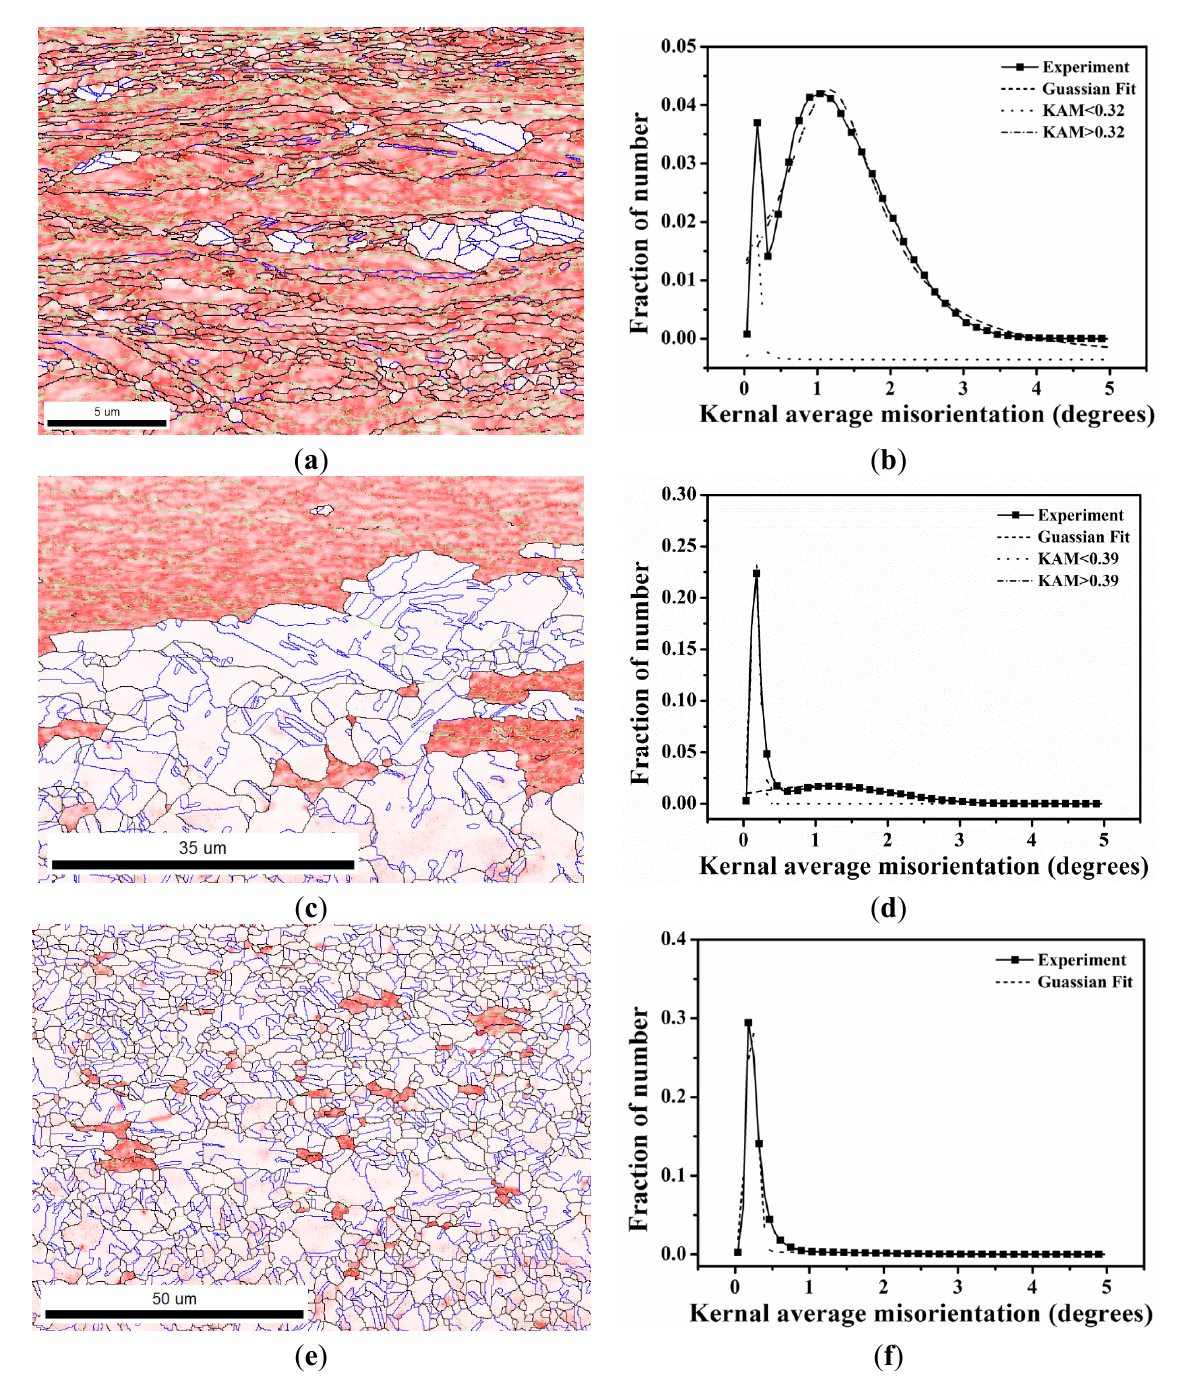
Figure 2. KAM maps after ( a ) 10 s; ( c ) 20 s; and ( e ) 60 s and KAM histogram after ( b ) 10 s; ( d ) 20 s; and ( f ) 60 s for 90% cold-rolled FePd alloy at 700 °C. The color coding is shown in Figure